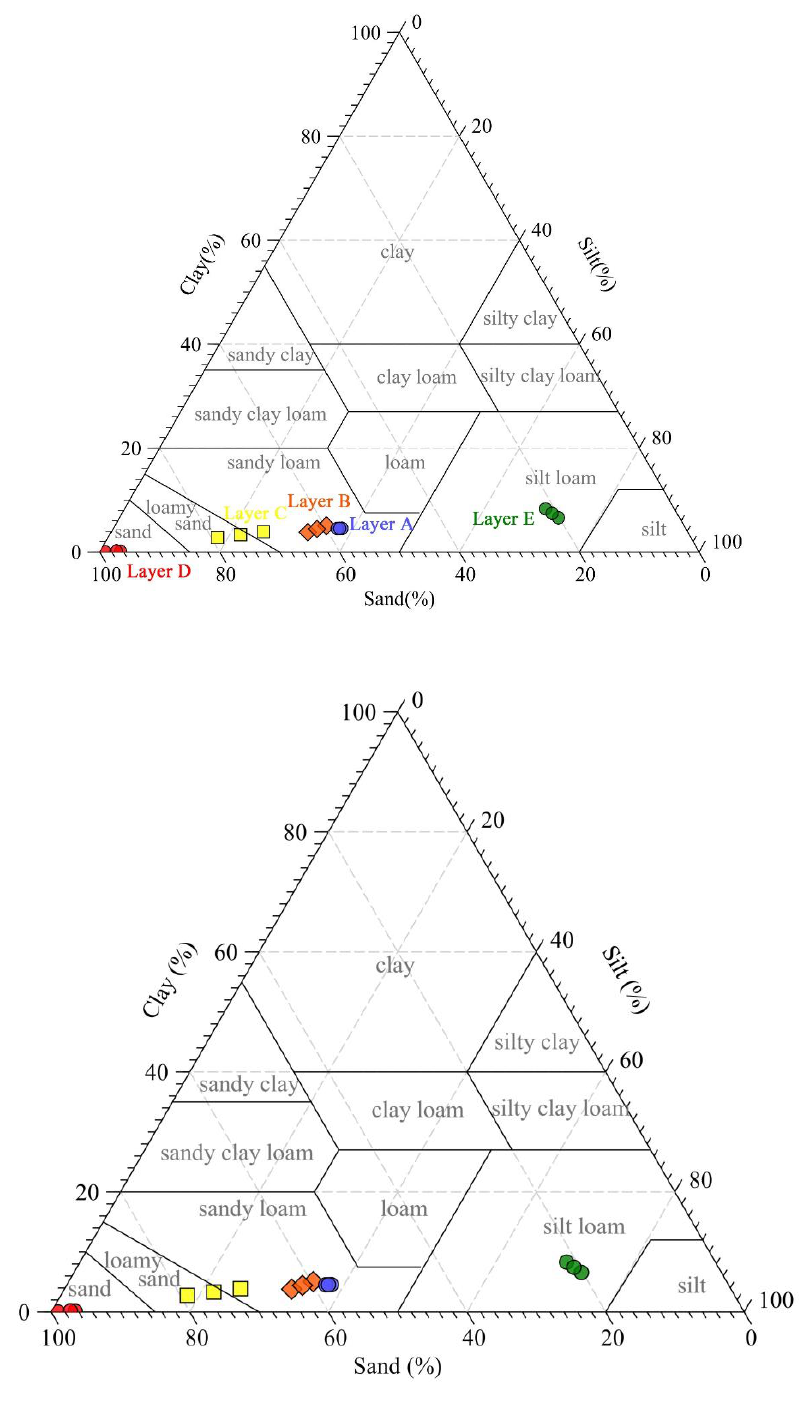
Figure 2. Soil texture distribution (USDA) of the soil samples collected from the research area.